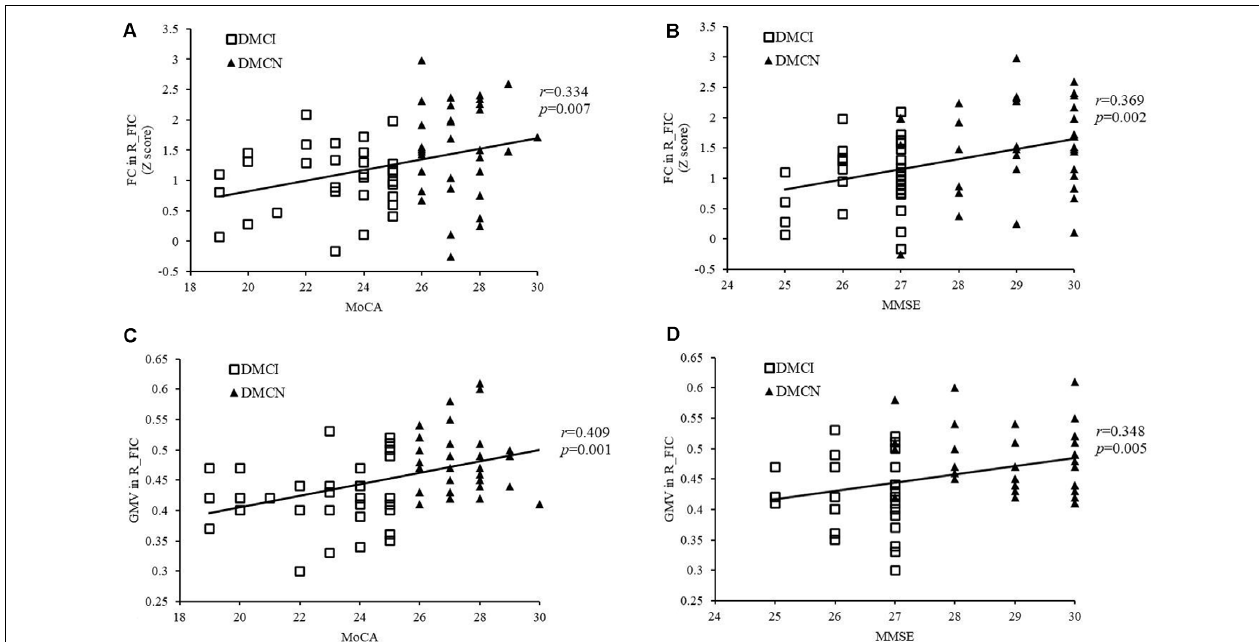
FIGURE 3 | Correlation between the right FIC and cognitive scores. (A) Correlation between FC in the right SN FIC and the MoCA score of patients with T2DM ( r = 0.334, P = 0.007). (B) Correlation between FC in the right SN FIC and the Mini-Mental State Examination (MMSE) score of patients with T2DM ( r = 0.369, P = 0.002). (C) Correlation between GMV in the right SN FIC and the MoCA score of patients with T2DM ( r = 0.409, P = 0.001). (D) Correlation between GMV in the right SN FIC and the MMSE score of patients with T2DM ( r = 0.348, P = 0.005).